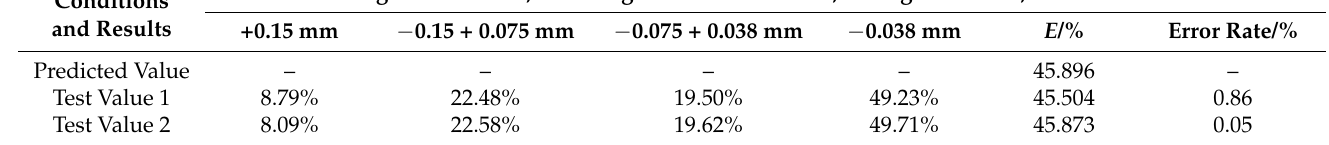
Table 15. Verification test results.